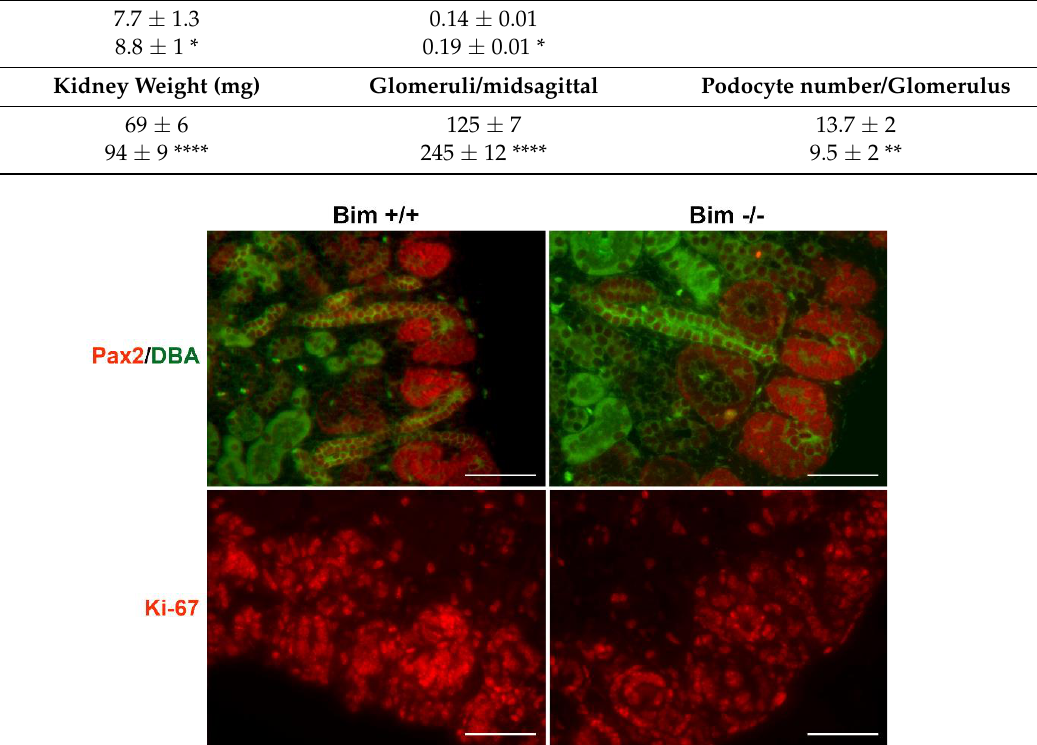
Figure 2. Nephrogenic zone appears less compressed in kidneys from Bim −/− mice. Kidneys from P0 mice were stained with anti-Pax2 (red) and DBA (green) in the upper panel. In the lower panel Ki-67 staining was conducted to identify proliferating cells. Data representative of six mice. Scale bar is 12.5 µm.